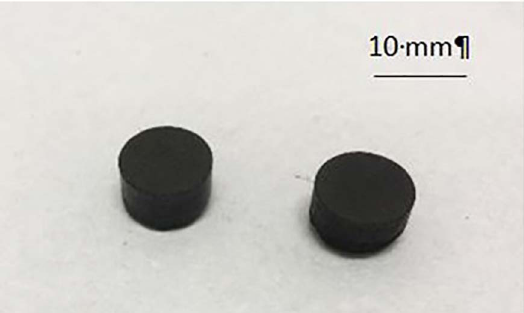
Figure 2. Optical image showing the samples of W2.5%Lig and W5%Lig after compaction at 440